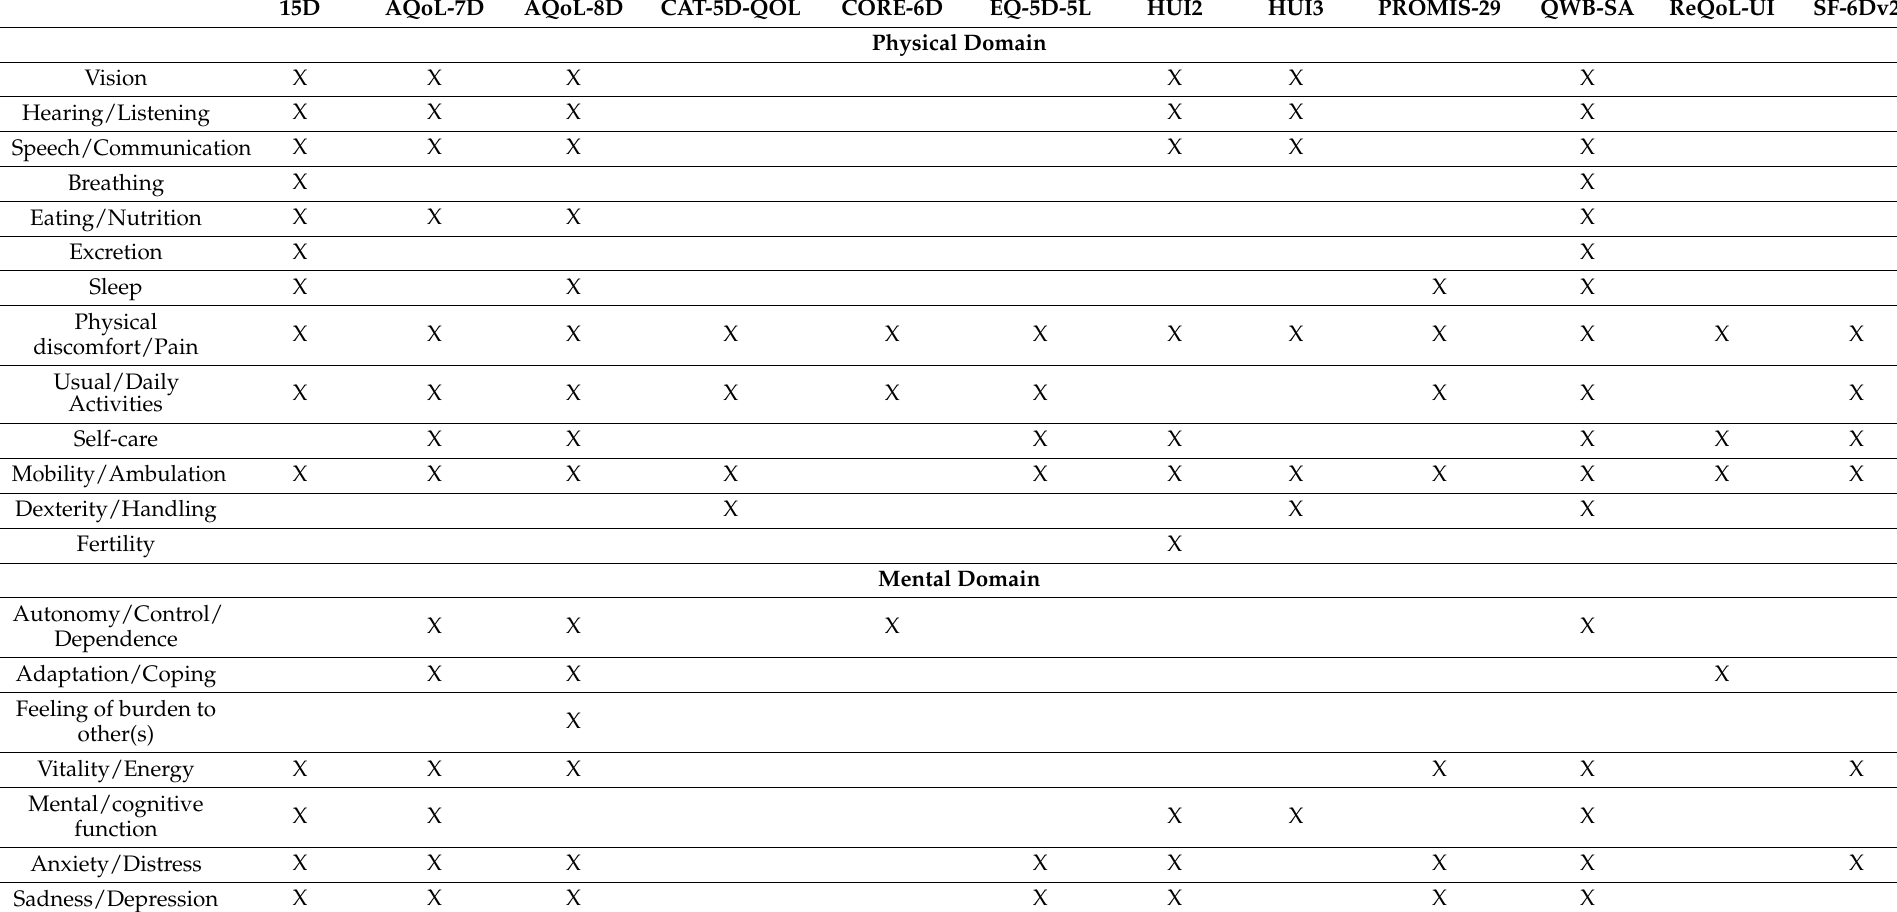
Table 1. Dimensions and levels selected in the generic